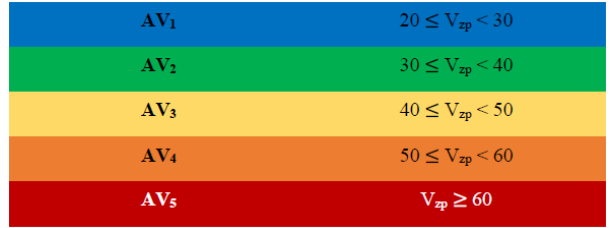
Table 1. The new ionospheric plasma index, AV, divided into five levels. The colors indicate the level of disturbance. V zp is given in meters per second.